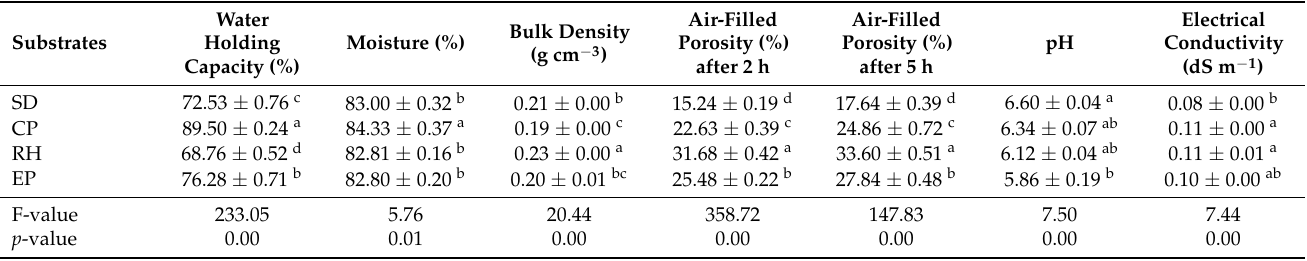
Table 1. Physical and chemical properties of substrate mixtures.